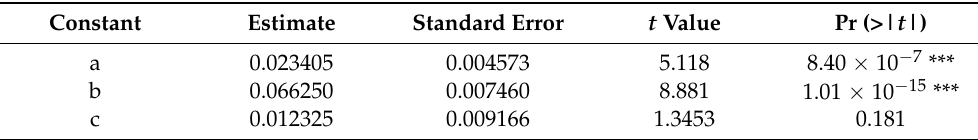
Table 6. Parameters of the extended exponential model describing the CO 2 efflux (g m − 2 h − 1 ) from undisturbed bare